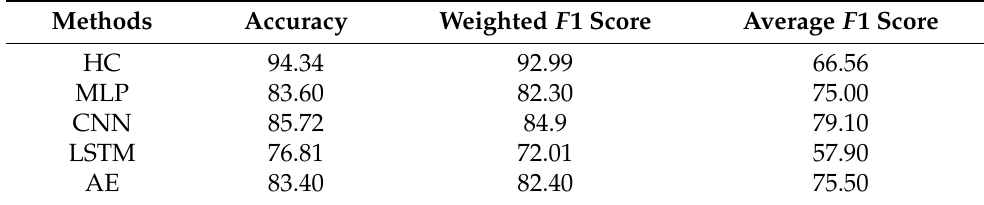
Table 4. SVM classification evaluation metrics (in percent) of different tested feature extraction models on the SHRP2 data